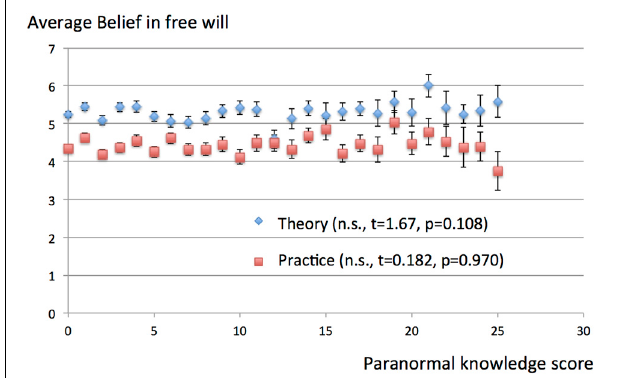
FIGURE 2 | Average belief in free will for paranormal knowledge scores. The scores for belief in free will (theory and practice) are averaged and plotted for subjects with particular paranormal knowledge scores. The possible range of scores for belief in free will was 1–7, while that for paranormal knowledge was 0–40. Vertical bars represent standard errors of the mean. There were no significant correlations between the paranormal knowledge score and beliefs in free will [theory ( t = 1 . 67, p = 0 . 108) and practice ( t = 0 . 182, p = 0 .